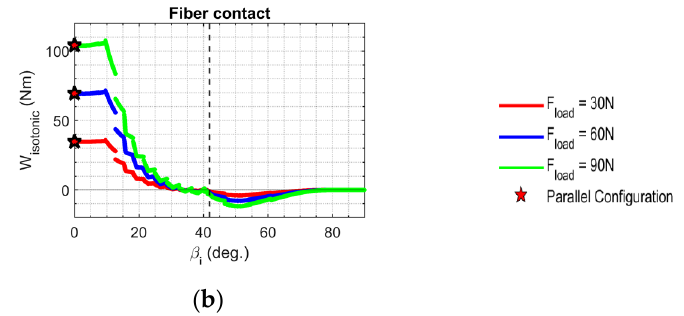
Figure 18. Variation in isotonic work output capacity of parallel ( β i = 0 ◦ ) muscle bundles with pinned boundary condition ( a ) and fiber contact boundary condition ( b ). The legend on the far right indicates the fiber pennation angle of the muscle topology.